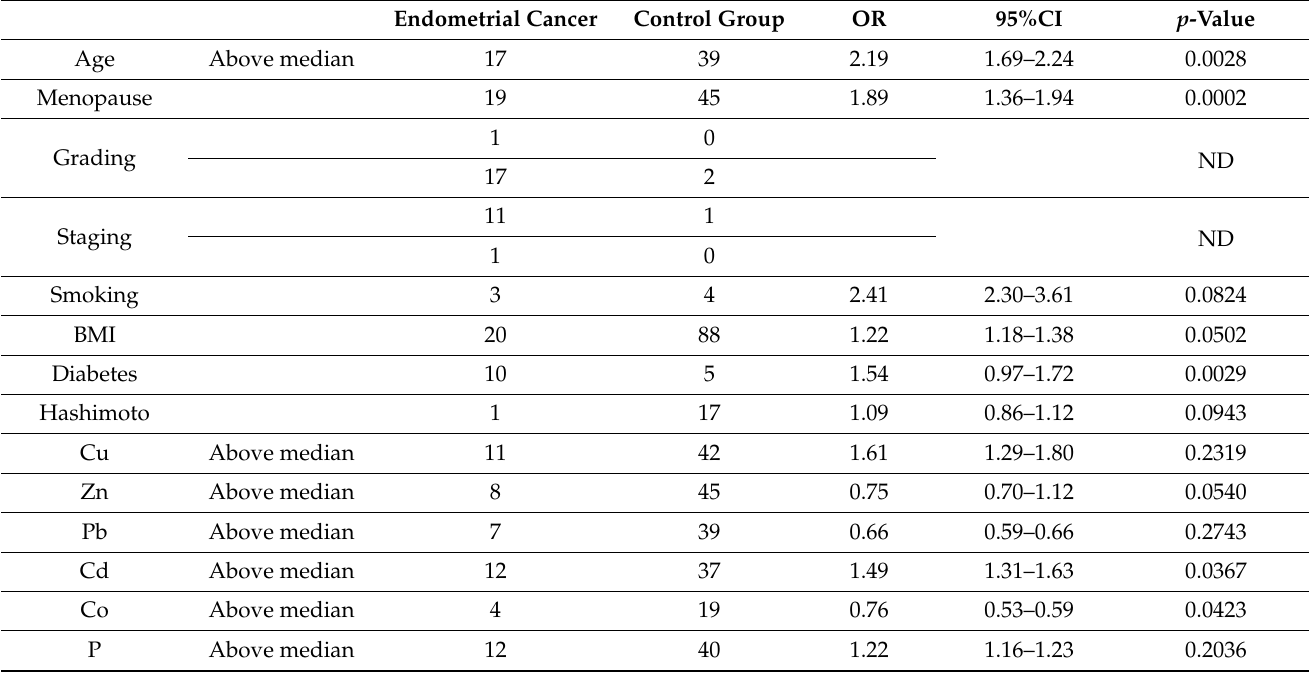
Table 6. Multivariate logistic regression